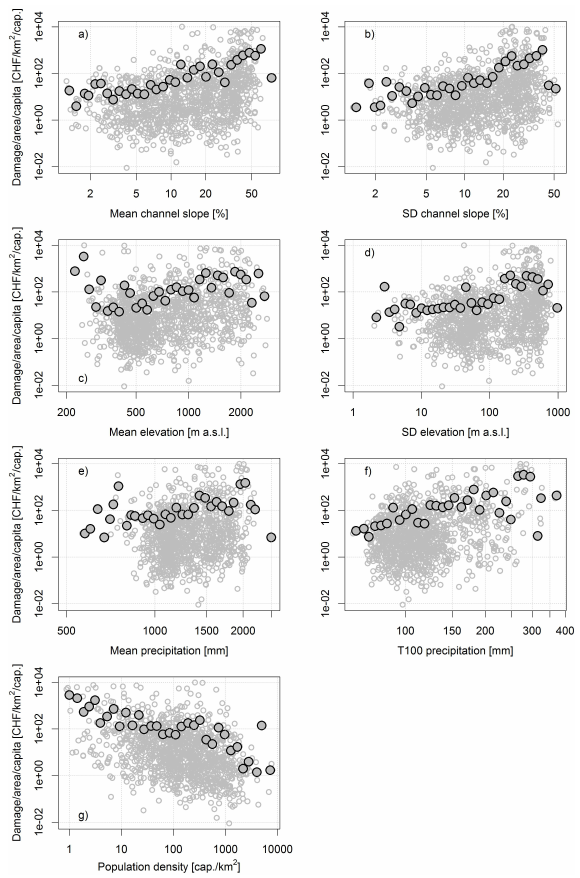
Fig. 9. Relation between municipal bedload damage costs normal- ized by area and population and (a) the mean/ (b) standard deviation of channel slope, (c) the mean/ (d) standard deviation of elevation, (e) the mean annual precipitation, (f) the 1-day rainfall with a recur- rence interval of 100yr, and (g) the population density. Grey circles represent the individual municipalities affected by bedload transport damage between 1972 and 2011. The black circles represent binned